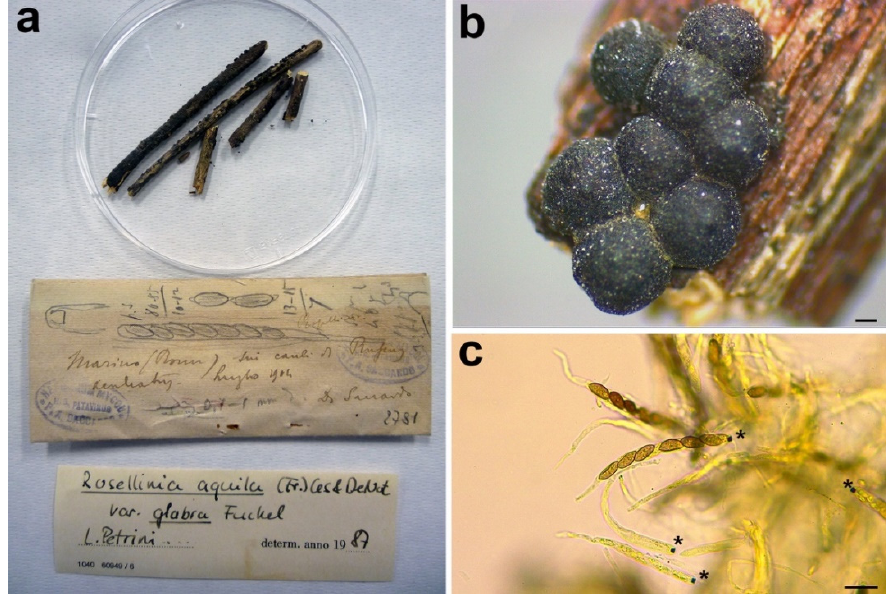
Figure 10. Rosellinia romana . ( a ) Original fungarium specimen. ( b ) Perithecia on natural substrate. ( c ) Asci with ascospores; black asterisks indicate the amyloid apical apparatus. Scale bars: ( b ) = 200 µ m; ( c ) = 20 µ